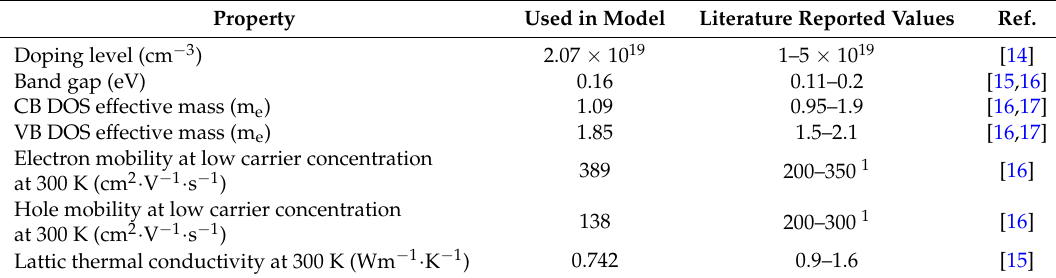
Figure 1. Modelled and experimental thermoelectric material parameters of n-type bismuth telluride as a function of temperature: ( a ) Seebeck coefficient; ( b ) electrical conductivity; ( c ) thermal conductivity and ( d ) ZT. Modelled data includes a number of different doping levels, with the best fit represented by 2.07 × 10 19 cm − 3 (orange). Table 1. Properties used to match modelled n-type bismuth telluride material to experimental data.